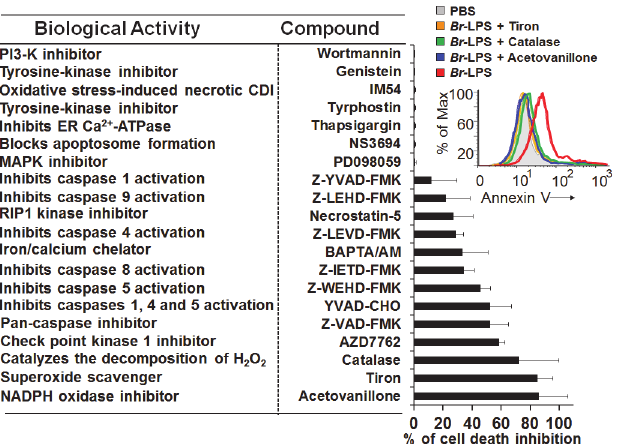
Fig 11. Inhibitory action of various compounds on the Br -LPS-induced PMN cell death. Prior to Br -LPS stimulation, samples were treated with wortmanin (50 nM), genistein (100 μ M), IM-54 (10 μ M), tyrphostin (250 μ M), thapsigargin (50 nM), NS3694 (10 μ M), PD098059 (50 μ M), Z-YVAD-FMK (10 μ M), Z-LEHD-FMK (10 μ M), necrostatin-5 (10 μ M), Z-LEVD-FMK (10 μ M), BAPTA/AM (10 μ M), Z-IETD-FMK (10 μ M), Z-WEHD-FMK (10 μ M), YVAD-CHO (50 μ M), Z-VAD-FMK (10 μ g/mL), AZD7762 (30 μ M), catalase (2800 U/ mL), tiron (2 mg/mL), acetovanillone (100 μ g/mL) or PBS. After treatment with the inhibitory compounds, samples were incubated with Br -LPS (1.5 pmol/mL) for 2 hours. Samples were further processed and analyzed by cytometry for cell death with Annexin V as described above. Geometric means of histograms displayed as relative units. In the upright corner, the read out procedure of the inhibitory action of tiron, catalase and acetovanillone is presented. Values were estimated as relative units of the geometric means of histograms. Each experiment was repeated at least three times.